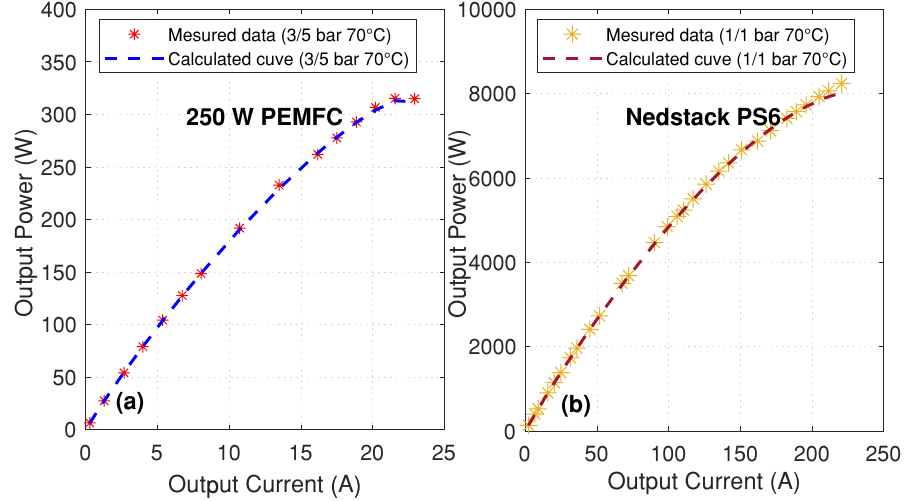
Figure 7. The current–power curve: ( a ) 250 W fuel cell; ( b ) NedStack PS6 fuel cell. The absolute deviation of each voltage point between the real and estimated data Div = V mes − V est of the two stacks (250 W PEMFC and NedStack PS6) for the best results of all 30 independent tests is displayed in Tables 7 and 8. Table 7. Estimated voltage and absolute deviation of the 250 W PEMFC.